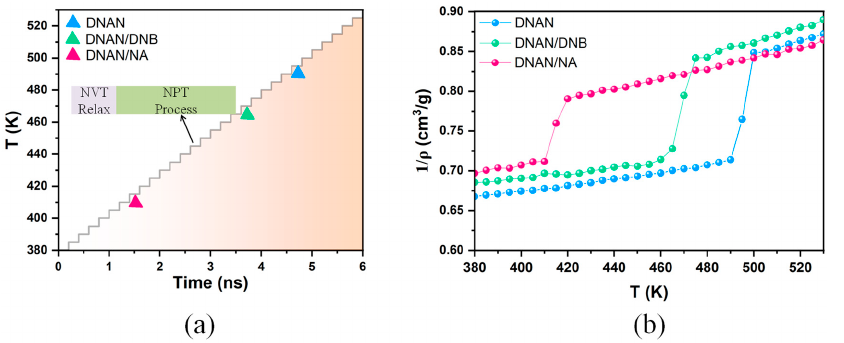
Figure 8. Schematic melting point simulation procedure ( a ) and inverse density vs. temperature for the three crystals ( b ). Blue, green, and pink represent DNAN, DNAN/DNB, and DNAN/NA, respectively. Insert view in ( a ) denotes the two stages for each temperature; purple and green represent 50 ps NVT relaxation and 150 ps NPT simulation, respectively.